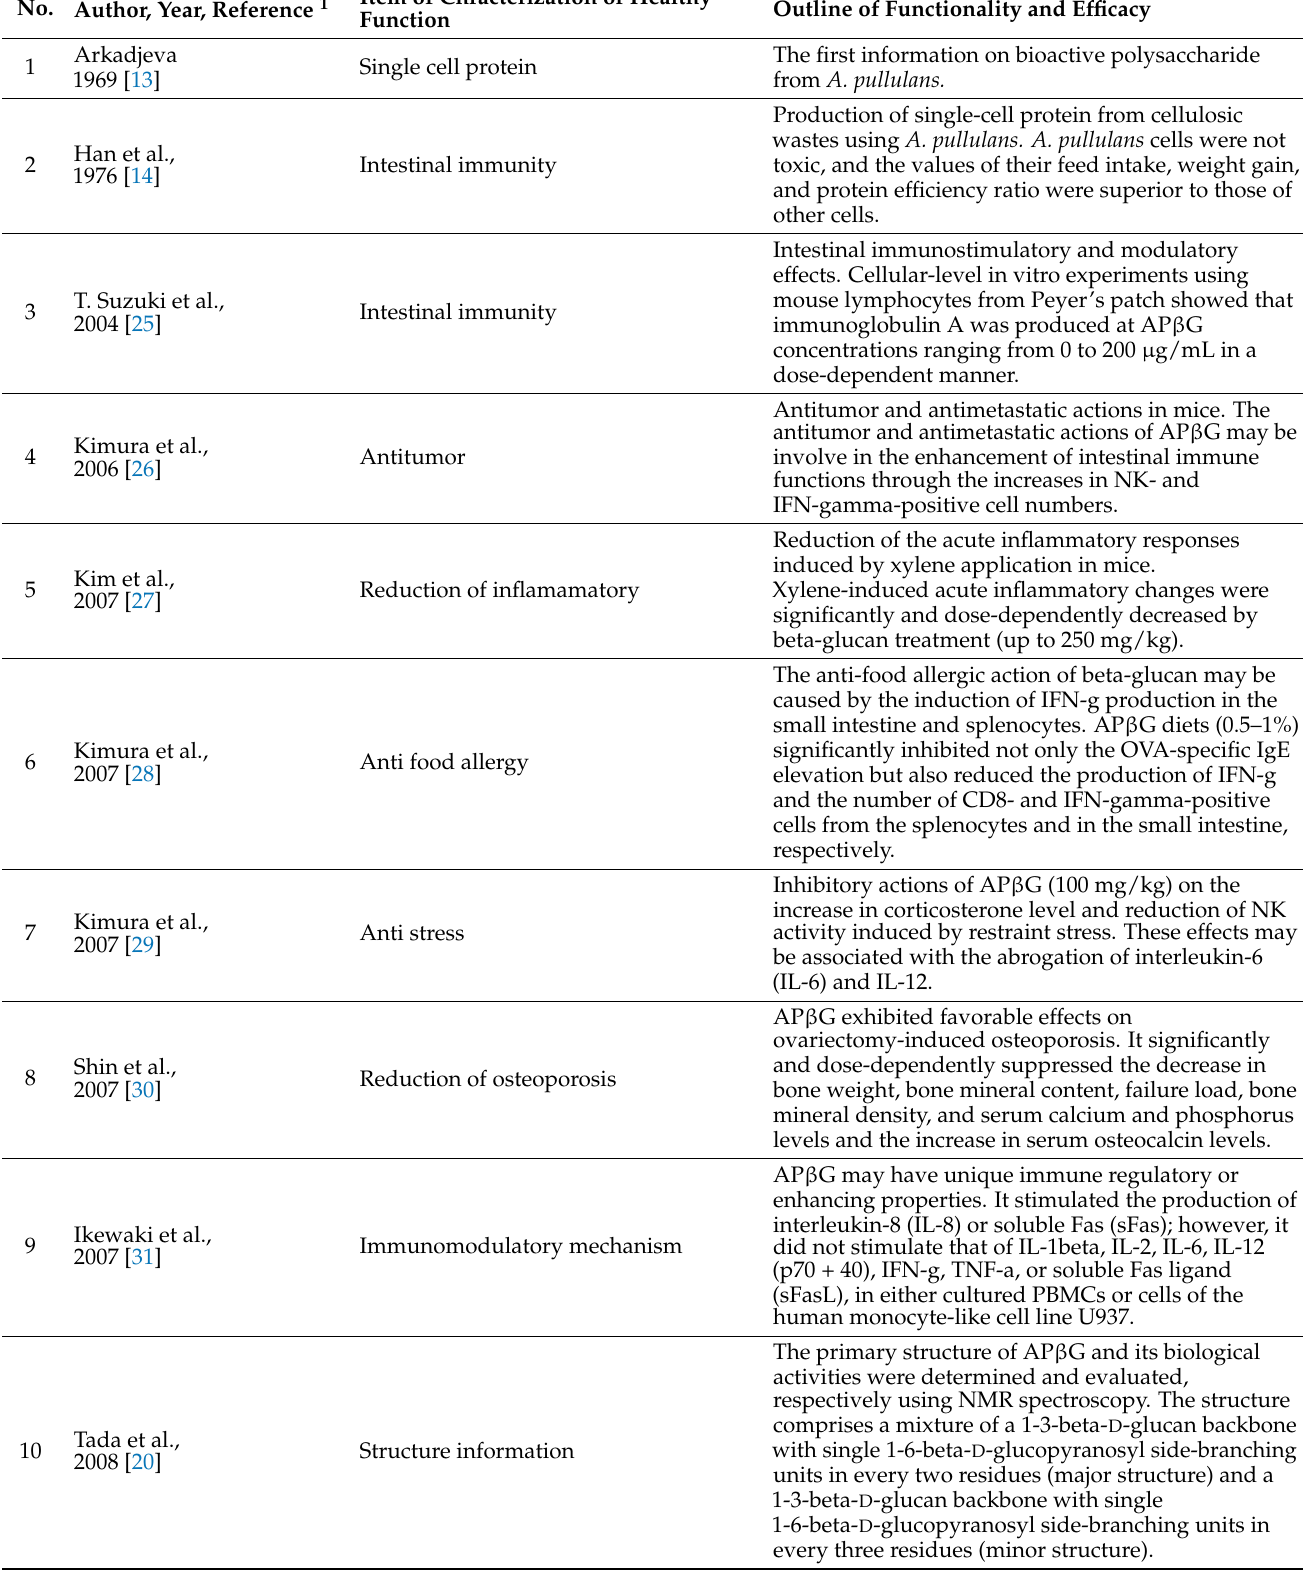
Table 2. Various bioactive functions of β -1,3-1,6-glucan from black yeast Aureobasidium pullulans (AP β